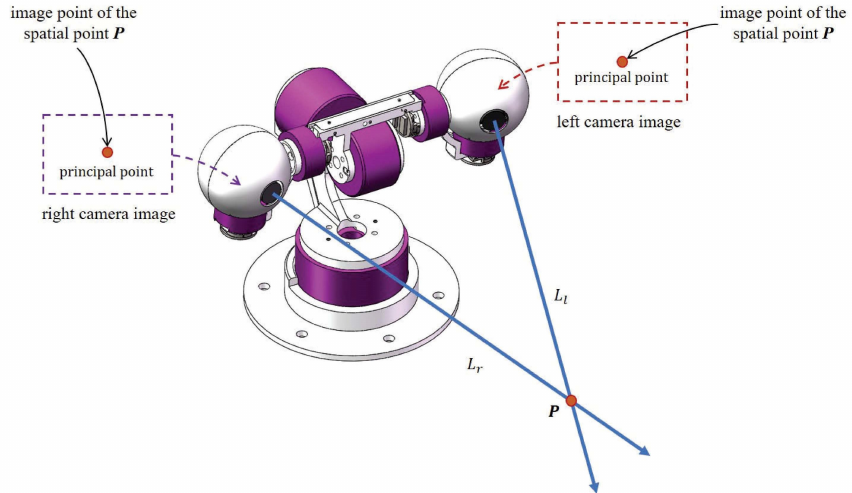
Figure 1. In our proposed method, we use eye gazing or visual servoing to actively adjust the view direction of each camera to keep the 2D image of a three-dimensional (3D) point P at the principal point. In other words, P is located at the fixation point. 3D triangulation could be performed through the intersection of two cameras’ optical